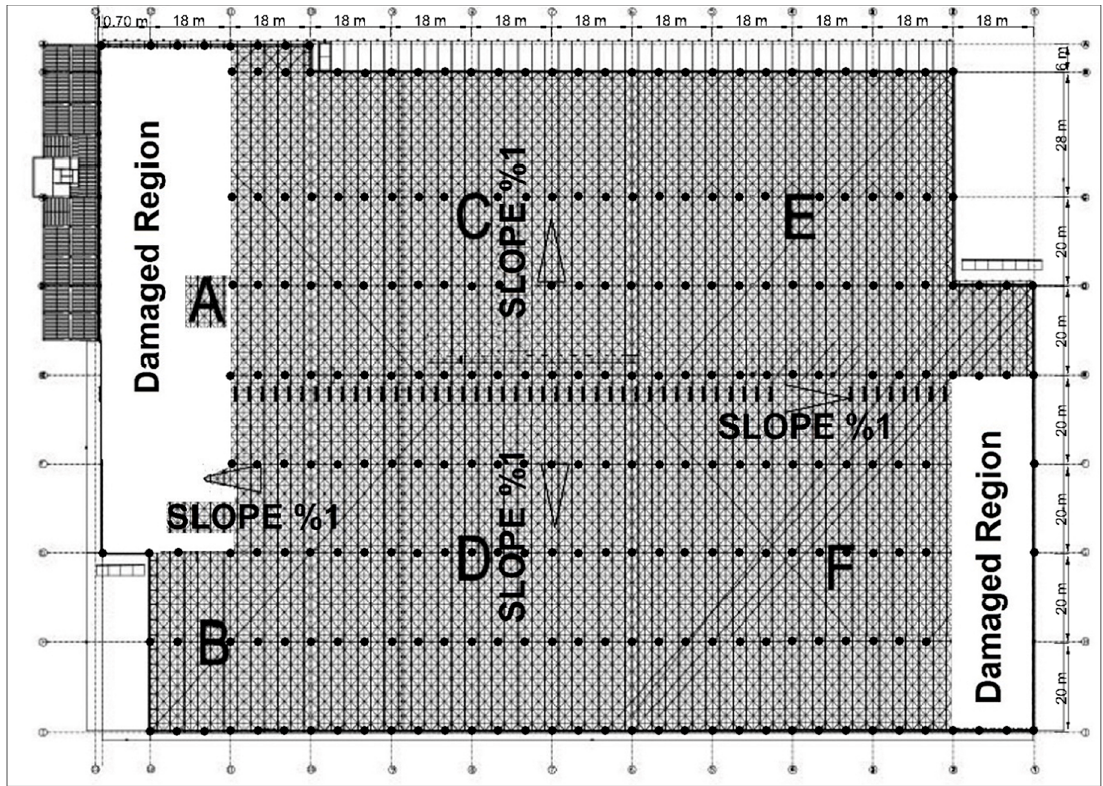
Figure 1. Layout and damaged regions of the roof structure.